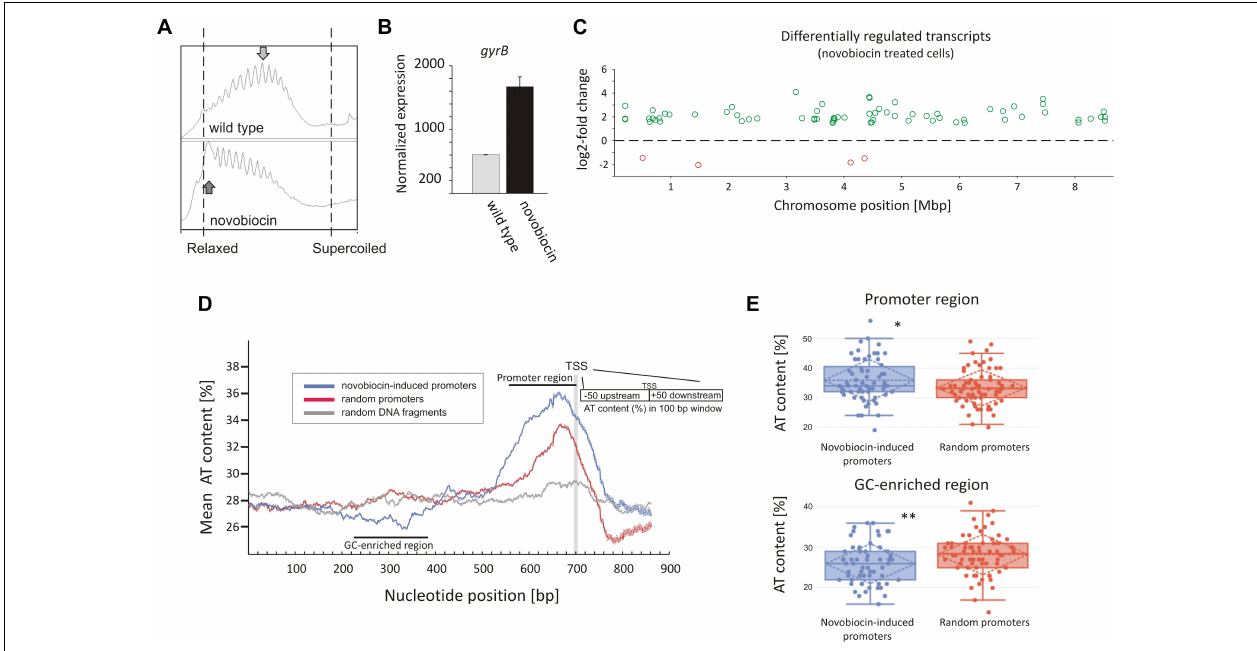
FIGURE 1 | Identification of novobiocin-sensitive genes in S. coelicolor . (A) Analysis of reporter plasmid supercoiling density. The reporter plasmid was isolated from untreated wild type strain (upper panel) and the same strain exposed to novobiocin (10 µ g/mL) for 10 min (bottom panel). The most abundant topoisomers identified under each condition are marked with arrows. (B) RNA-Seq based gyrB expression normalized by the upper quartile, in the untreated wild type strain (gray) and the novobiocin-treated strain [as described for panel (A) ] (black). (C) The chromosomal localization of the novobiocin-sensitive genes. Differentially upregulated (green) and downregulated (red) transcripts in the S. coelicolor culture following novobiocin exposure (as in panel A ) were identified using log2-fold changes > 1.5; p -value < 0.05 thresholds. (D) Analysis of the average AT content in the promoter regions of novobiocin-sensitive genes (blue) in comparison to the random promoters (red) and random chromosomal sequences (gray). The transcriptional start site (TSS), promoter region and GC-enriched region identified upstream of novobiocin-sensitive promoters are marked. (E) The box plot comparison of AT content within the promoter region (upper panel) and GC-enriched region (bottom panel) of novobiocin-sensitive (blue) and randomly selected (red) promoters. The asterisks indicate the calculated p -value < 0.05 ( ∗ ) or < 0.01 ( ∗∗